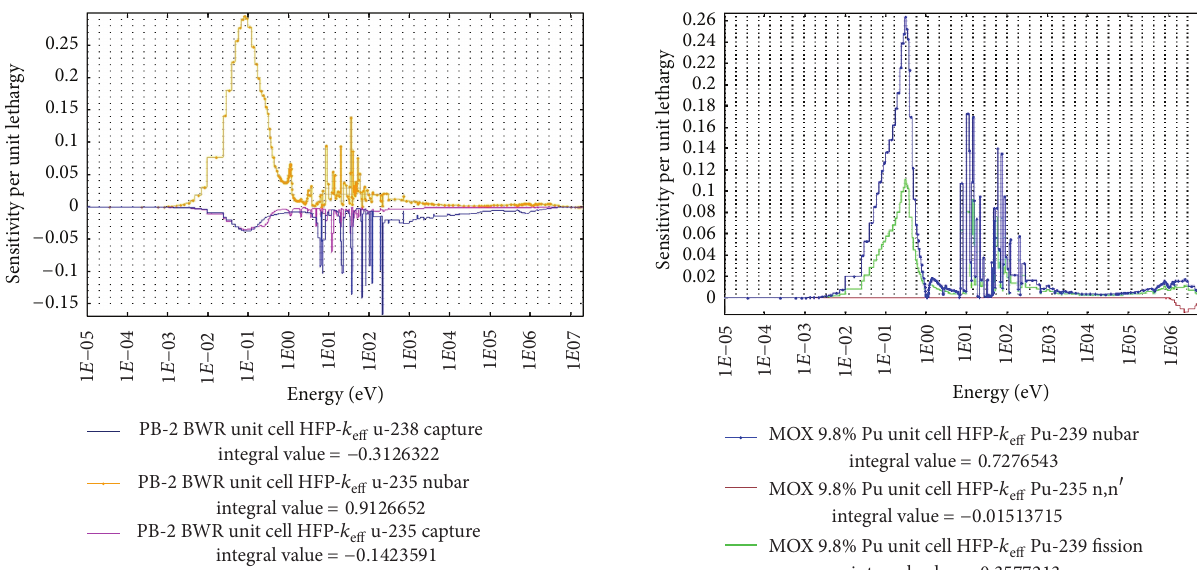
sensitivity profiles for the GEN-III unit cell case (HFP eff 𝑘𝑘